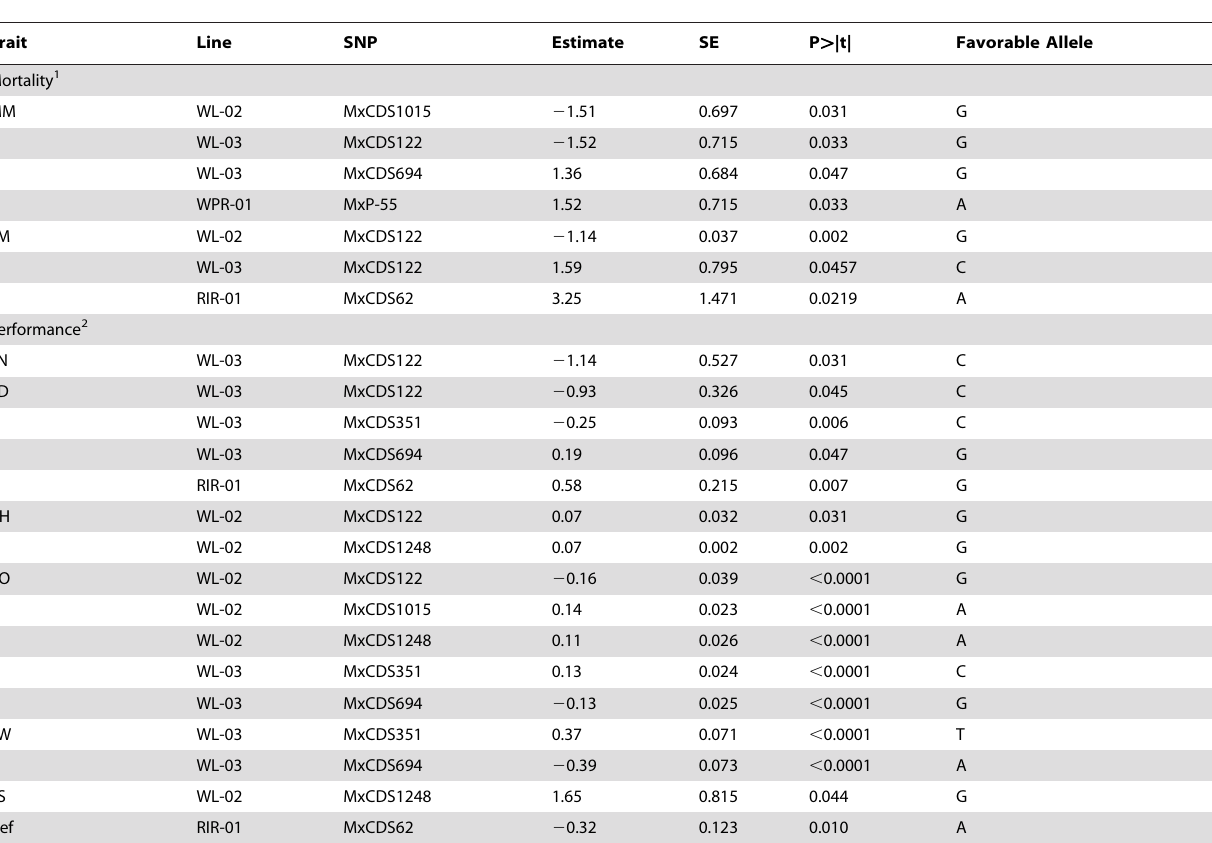
Table 5. Mx SNP with a significant allele substitution effect, and allele with favorable effect by trait.